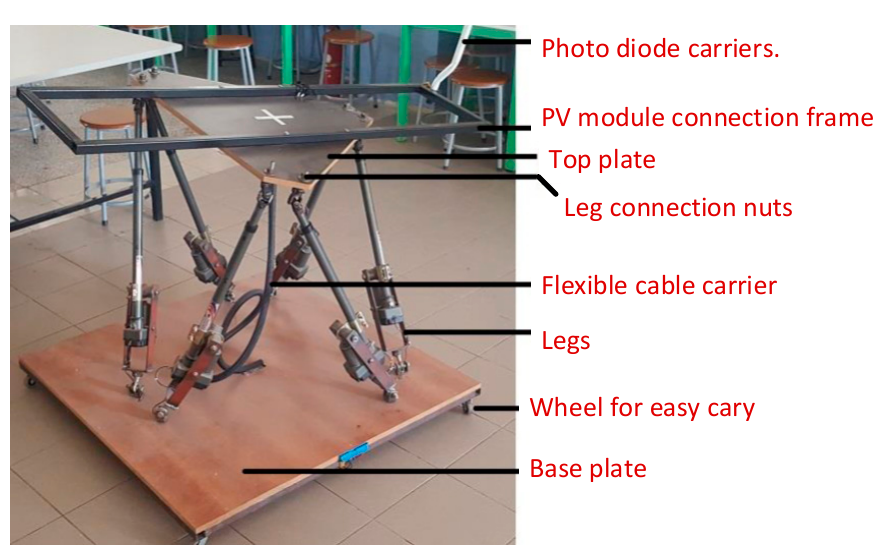
Figure 10. Mechanical structure of the Stewart platform for sun tracking application.